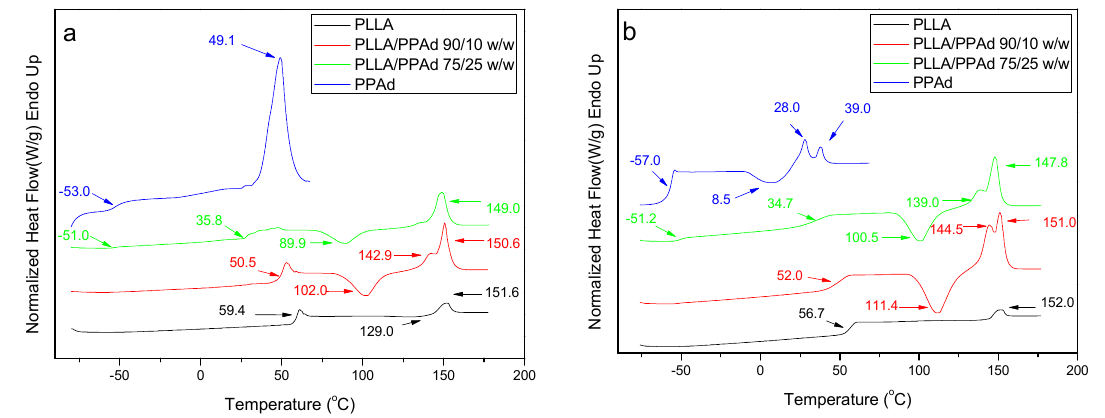
Figure 6. Di ff erential ( a ) first heating and ( b ) second heating scanning calorimetric thermograms of neat polymers and synthesized copolymers. Table 2. Glass transition temperature ( T g ), cold crystallization temperature ( T cc ) and melting temperature ( T m ) of PLLA, PPAd and their copolymers.